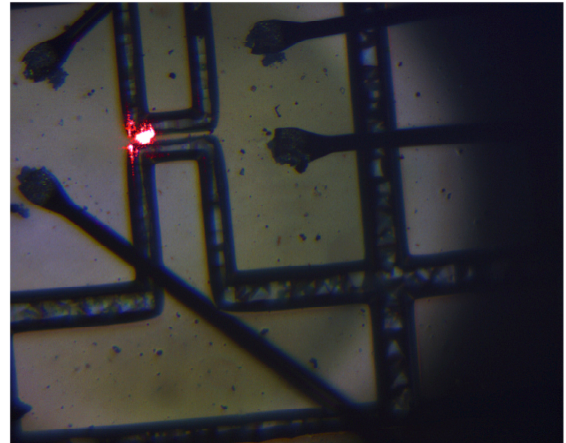
Figure 2. Optical microscope image of a typical LSMO FSM coated with a 30 nm thick gold layer to improve optical reflectivity. The detecting laser spot and the current/voltage pads are also